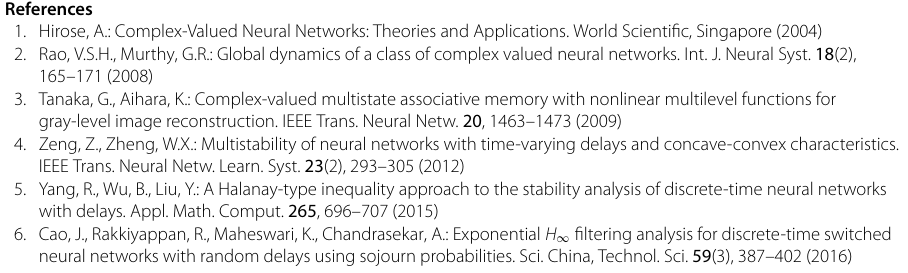
complex domain, we presented some sufficient conditions to guarantee the existence of a unique equilibrium point for the complex-valued neural networks. In addition, by con- structing appropriate Lyapunov–Krasovskii functionals, and employing the matrix in- equality techniques, we obtained several conditions for checking the robust stability of the complex-valued neural networks which are established in LMIs. Finally, two numer- ical examples have been given to illustrate the effectiveness of the proposed theoretical